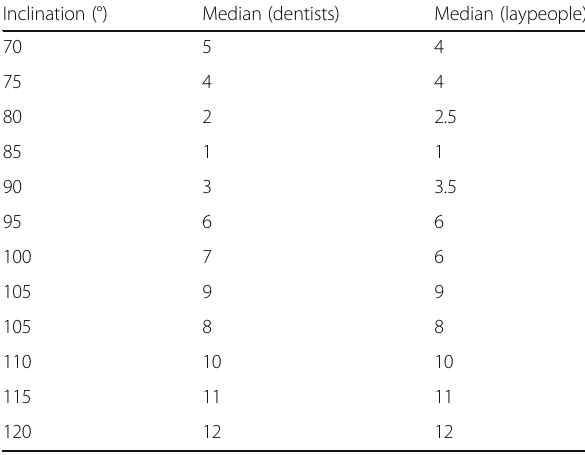
Table 2 Ranking of images by clinicians compared with laypeople in order of